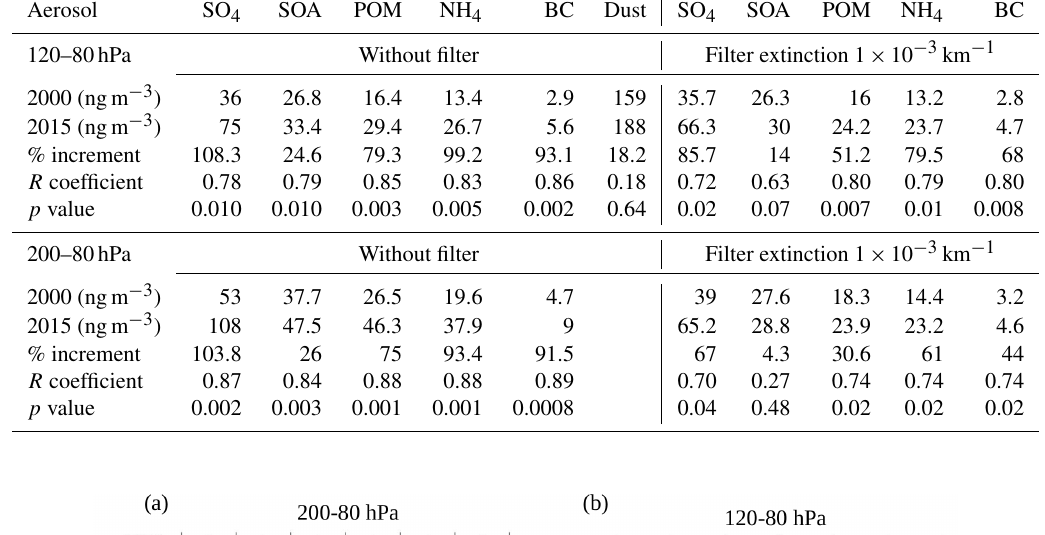
Table 2. Averaged aerosol mass concentration and percentage of the increase from 2000 to 2015 for SO 4 , SOA, POM, NH 4 and BC, averaged for the summer period July–August at 20–35 ◦ N, 60–100 ◦ E between 120–80hPa and 200–80hPa, without and with the extinction filter applied. The R coefficient from Fig. 5b to e and the respective p value are also reported.